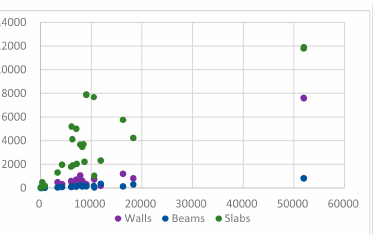
Figure A1. Distributions of the amounts of rebar by total floor areas by